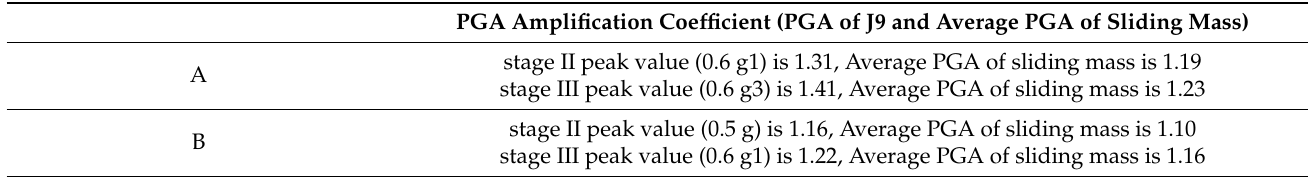
Table 7. PGA amplification